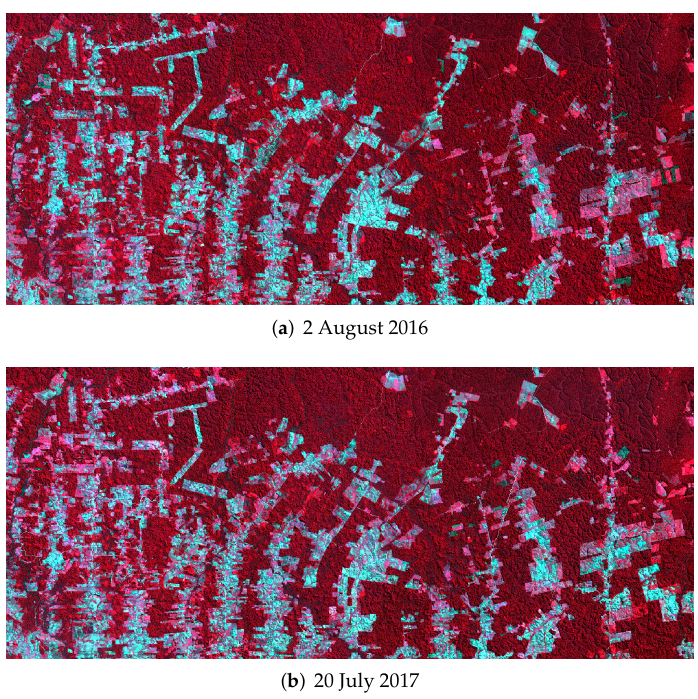
Figure 2. Landsat 8-OLI false-color composite (bands 5,4,3) of the study area.